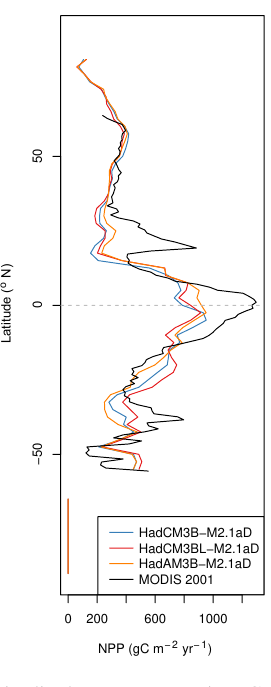
Figure 10. The latitudinal average NPP in gCm − 2 yr − 1 . CMIP5 models without dynamic vegetation plotted here are CCSM4 and IPSL-CM5A-LR. CMIP5 models with dynamic vegetation plotted here are MIROC-ESM and